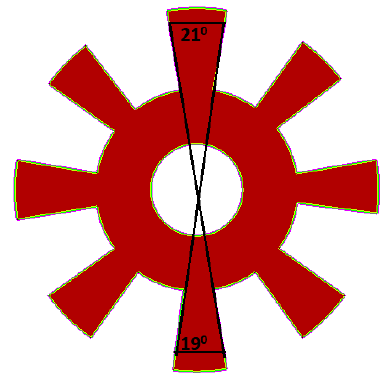
Figure 23. Cross-section of teeth paired rotor.